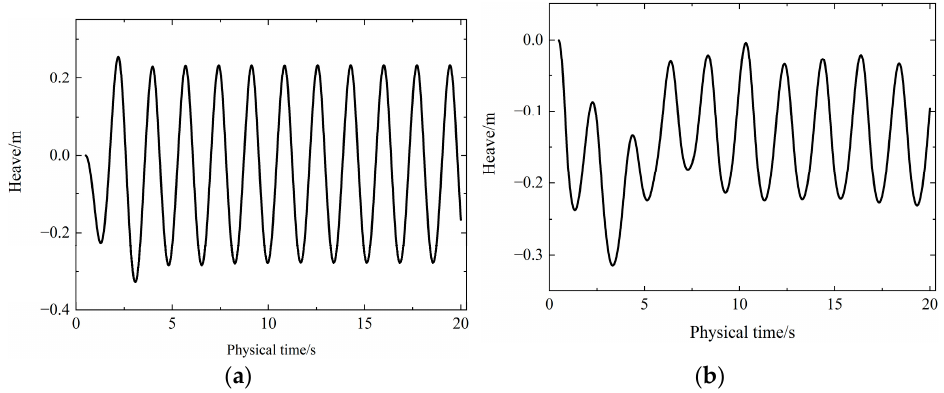
Figure 22. The time history curve of heave amplitude under case 6: ( a ) monohull; ( b ) pentamaran.